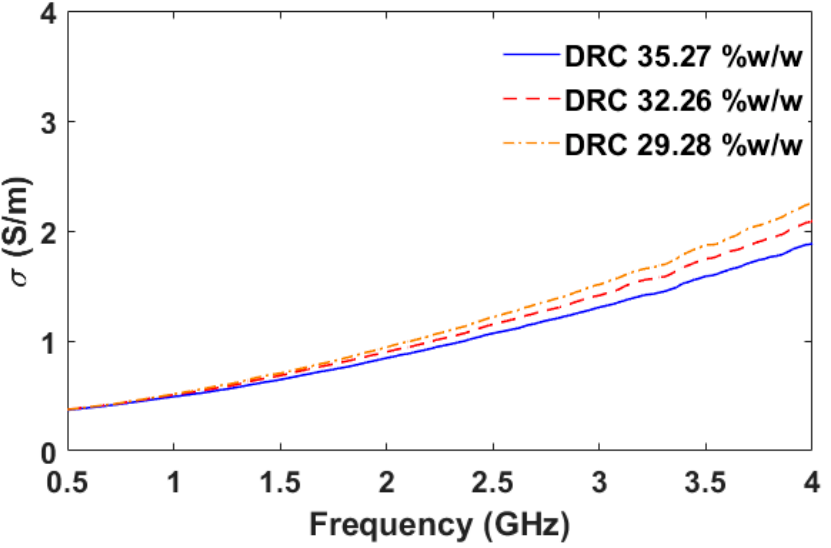
Figure 21. Electrical conductivity of natural latex samples with different DRCs over the frequency range of 0.5–4.0 GHz at the temperature of 25 °C.